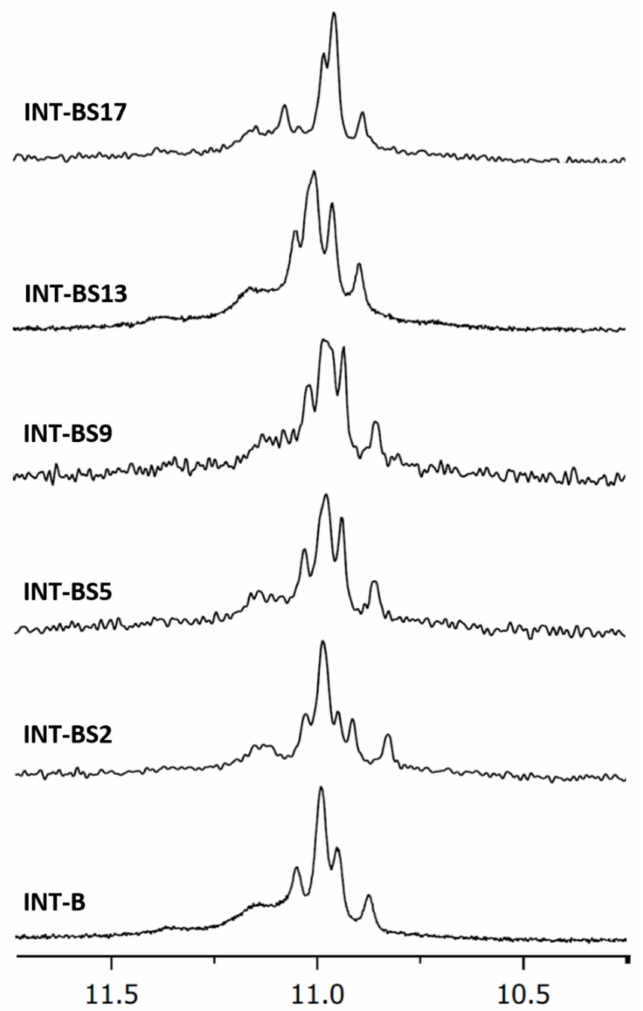
Figure 2. Imino proton regions of the 1 H-NMR spectra (400 MHz) of T30175 ( INT-B ) and its investi- gated analogues. See Section 3 for experimental